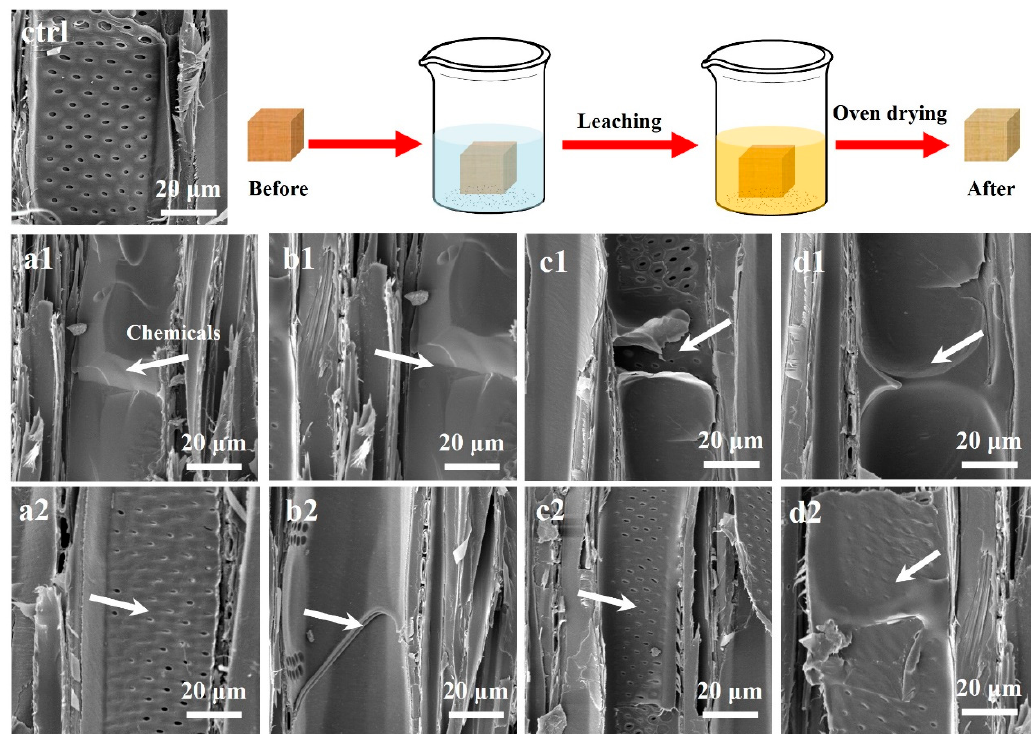
Figure 7. Micrographs of the tangential sections of the wood samples. The magnification is 20 µ m, and the arrows point to the curing chemicals. Among the untreated wood samples (Ctrl), 10% DM + 10% MA were modified by 103, ZC-103, 120, and ZC-120 and are shown in ( a1 ), ( b1 ), ( c1 ), and ( d1 ). The micrographs of the resolidified products after the leaching test are shown in ( a2 ), ( b2 ), ( c2 ), and ( d2 ), which correspond to ( a1 ), ( b1 ), ( c1 ), and ( d1 ).